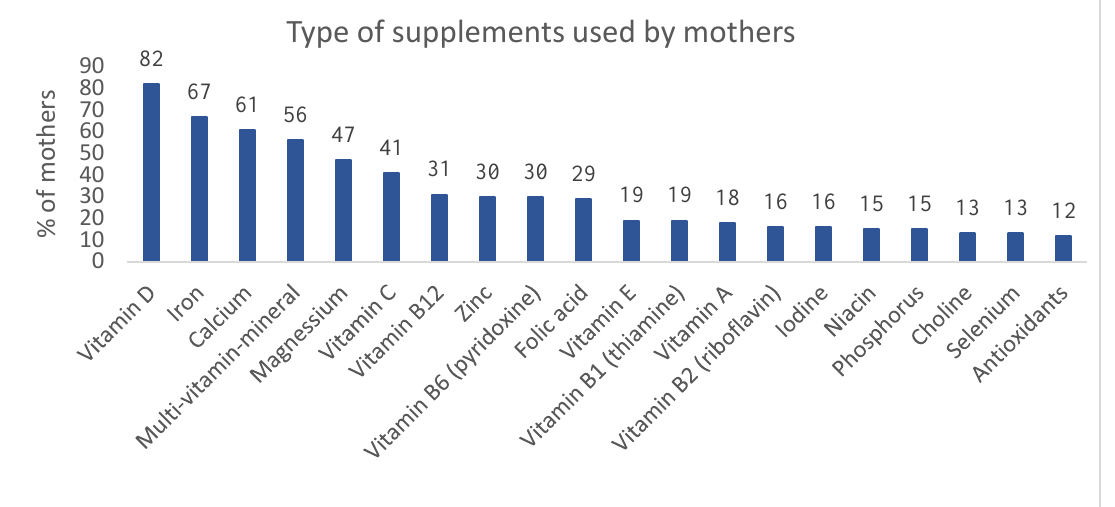
Table 3. The frequency and duration of use of single vitamin/or mineral and multi-vitamin-mineral supplements among mothers.